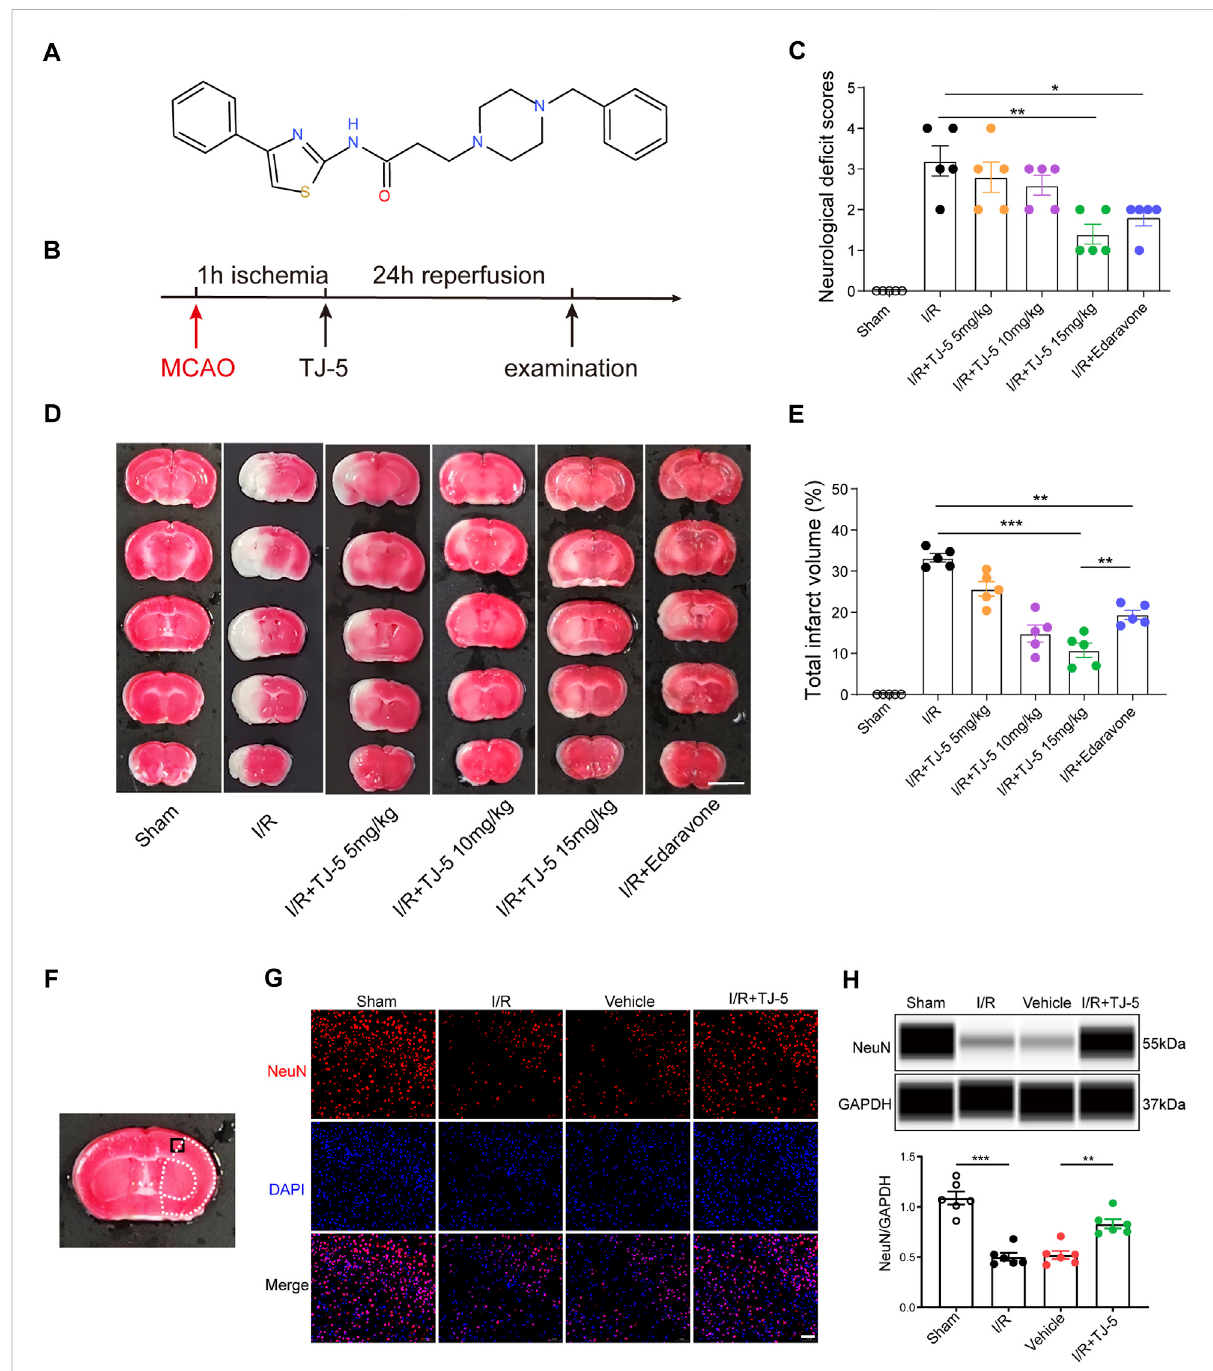
FIGURE 1 Neuroprotective effect of TJ-5 treatment in CIRI mice. (A) The molecular structure of TJ-5. (B) Experimental timeline of TJ-5 treatment in CIRI mice. (C – E) Representative TTC-stained slices at 24 h after reperfusion (scale bar = 5 mm) and statistical analysis of neurological de fi cit score and infarctvolume.Valuesaremean±SEMandanalyzedbytwo-wayANOVA.(* p < 0.05,** p < 0.01,*** p < 0.001). (F) Blackboxedareaillustratescortical region represented in the NeuN, TUNEL and Iba-1 images. White dashed line areas illustrate ischemic core (medial) and peri lesion (lateral) regions. (G) RepresentativeNeuNimmuno fl uorescencestainingimage(scalebar=50 μ m). (H) NeuNproteinlevelsinthebrainwereanalyzed.Allthe experiments were repeated three times. Values are mean ± SEM. (** p < 0.01, *** p <